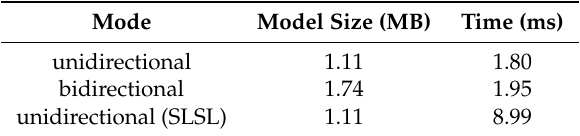
Table 6. Model size and Time. Value of model size denotes the total size of the model parameters. Value of time denotes the average time of processing per scan line on the test dataset. In the unidirectional mode and the bidirectional mode, scan lines are processed in batch. In the scan line-by-scan line (SLSL) unidirectional mode, scan lines are processed in sequence with the same model parameters as the unidirectional mode, which means that segmentation results of the unidirectional mode and SLSL unidirectional mode are the same.